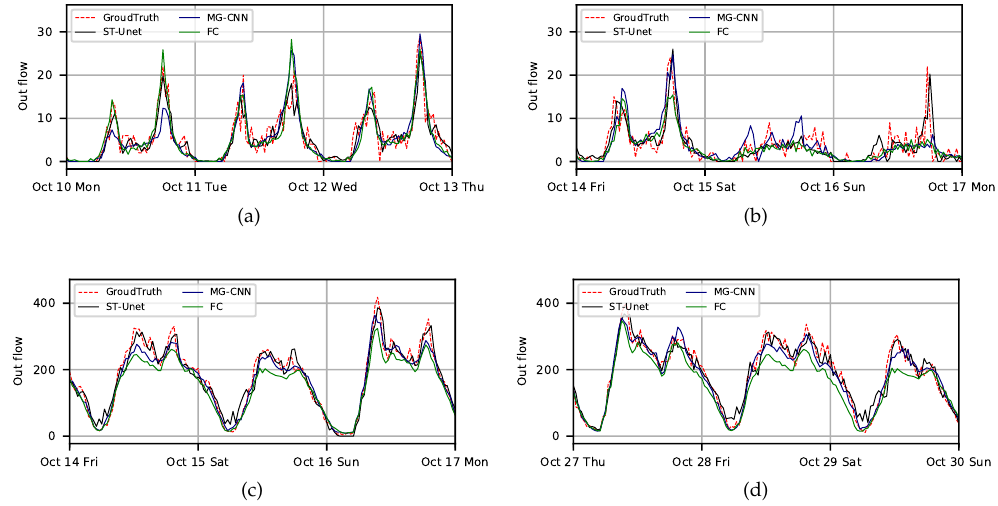
Figure 10. ( a , b ) NYC: Forecast out-flow results for a station [ id =498, Broadway & W 32 St] from 10/10/2016 to 12/10/2016 and 14/10/2016 to 16/10/2016, where 10/10/2016 is holiday, and 15–16/10/2016 is a weekend; ( c , d ) TAXI: Forecast out-flow results for a station [ id =161, Midtown Center] from 14/10/2017 to 16/10/2017 and 27/10/2017 to 29/10/2017, where 14–15/10/2017 is weekend, and 29/10/2017 is a rainy